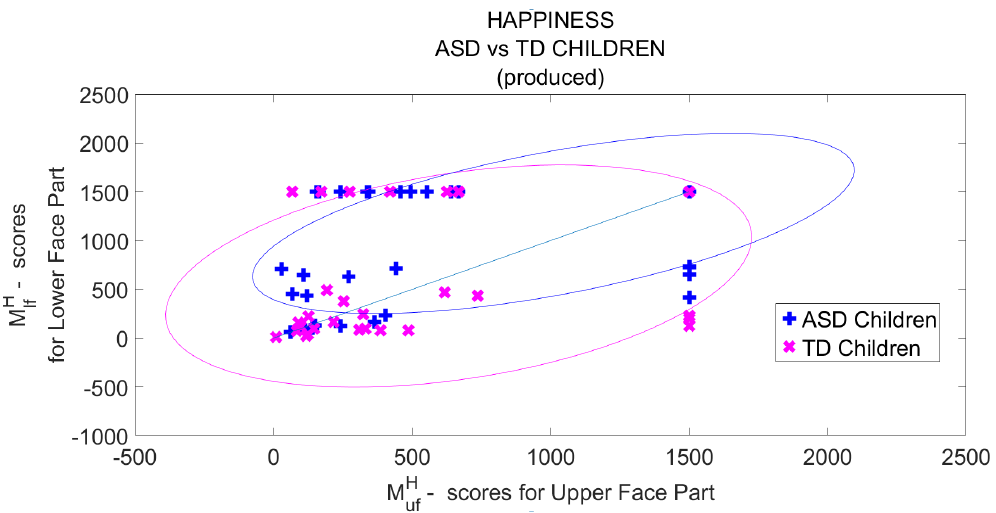
Figure 13. Comparison of the scores computed for the production of Happy expressions by ASD and TD